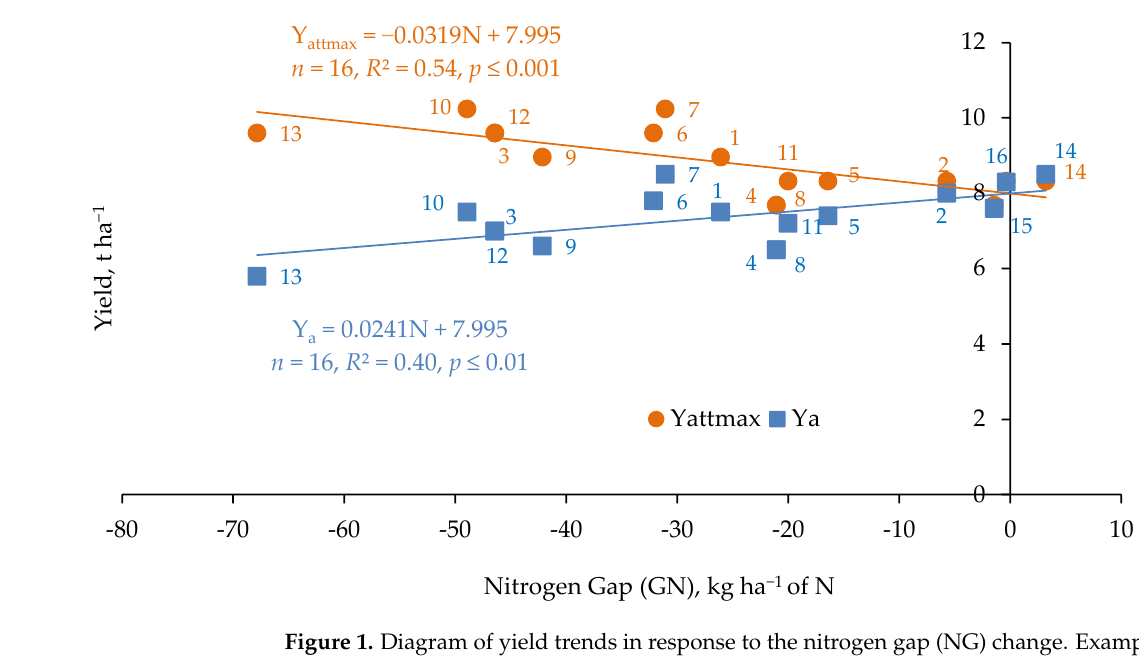
Figure 1. Diagram of yield trends in response to the nitrogen gap (NG) change. Example for winter wheat (based on Grzebisz and Łukowiak [8]). Key: Y attmax —maximum attainable yield; Y a —actual yield; 1–16 are the field numbers.